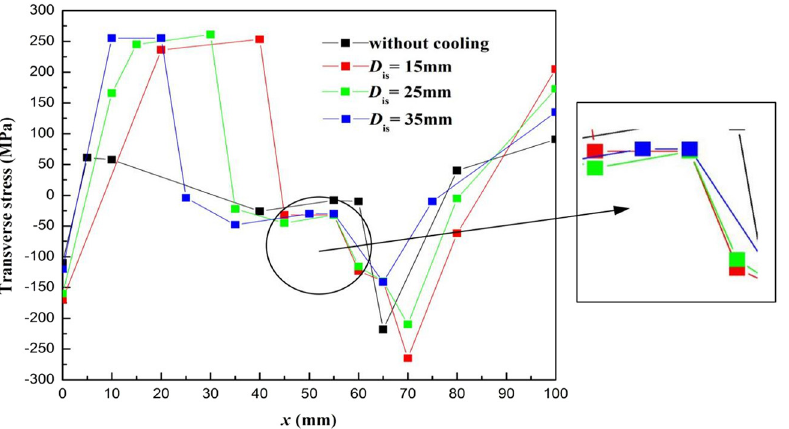
Figure 13: Transverse stress distributions along weld center line of di ff erent distances between cooling source and heat source when t = 30